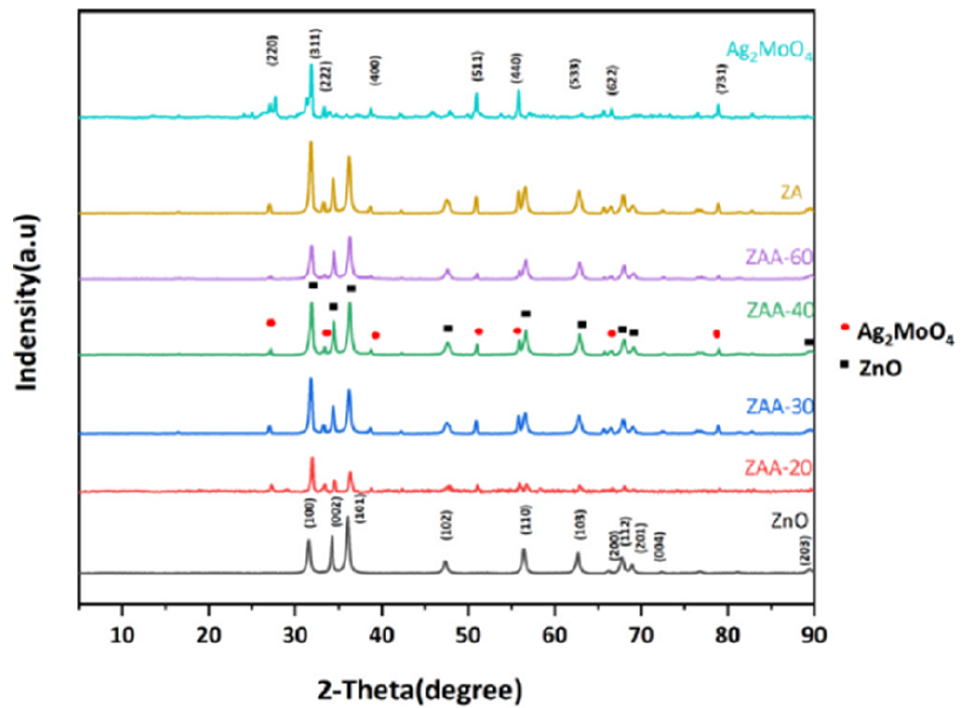
Figure 18. XRD patterns of ZnO, Ag 2 MoO 4 /Ag, ZA, and ZAA nanocomposite with different proportions. Reprinted/adapted with permission from Ref. [184]. Copyright© 2022, Elsevier B.V.